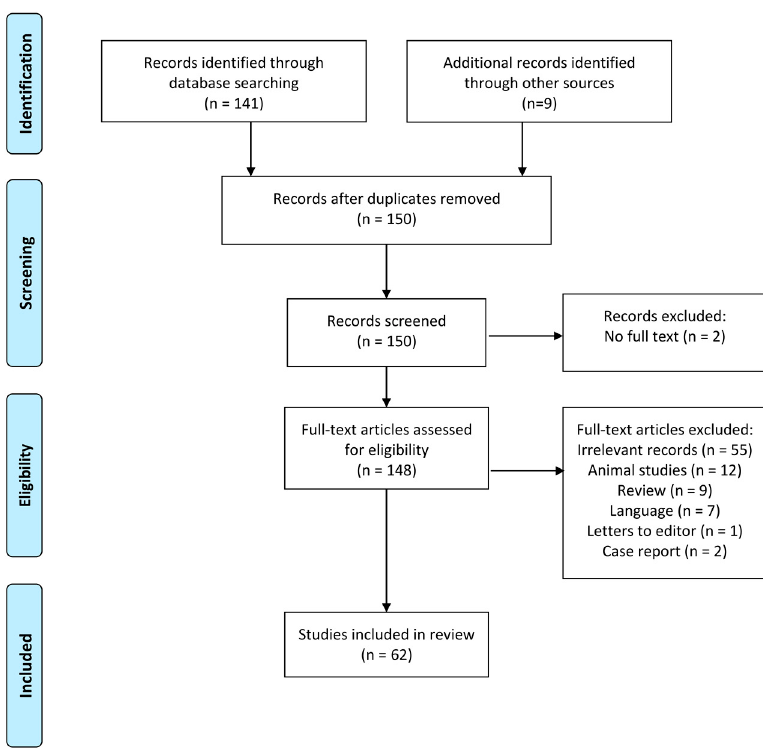
Figure 2. Flow diagram for the selection of studies for review based on the preferred reporting items for systematic reviews and meta-analyses (PRISMA) 2009 statement.